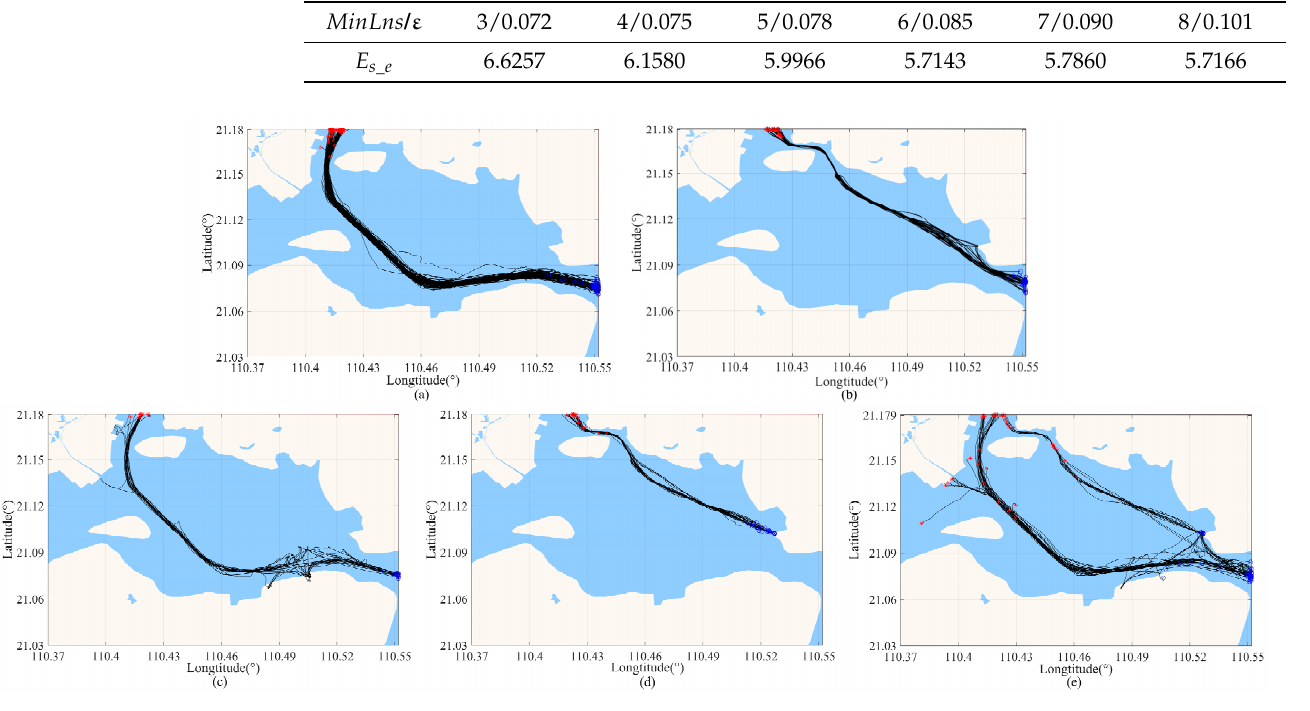
Figure 16. DBSCAN clustering results of Figure 9c with 𝑀𝑖𝑛𝐿𝑛𝑠 = 5 and 𝜀 = 0.085 . ( a ) Class A; ( b ) Class B, 18; ( c ) Class C, 22; ( d ) Class D,13; ( e ) Class E, 36; ( f ) Class F, 98; ( g ) Class G, 5; ( h ) ab- normal trajectories, 30. 4.4. Traffic Feature Analysis Based on the clustering and dividing results of the trajectories in the Zhanjiang Port, the traffic characteristics on different routes entering and leaving port are analyzed. We mainly focus on the features of speed, steering, and abnormal trajectories. 4.4.1. Analysis of Speed Feature (1) Speed Analysis of outgoing and incoming ships The trajectories of entering and leaving ships are analyzed using the trajectories on the prescribed channel, so the trajectories in Figure 16a are chosen as analysis objects for incoming ships, and the trajectories in Figure 14a are chosen for outgoing ships. The sta- tistics of speed are shown in Figure 17. The average speed of leaving ships is 7.67 knots, while that of entering ships is 7.69 knots, and the speed distribution is almost the same.